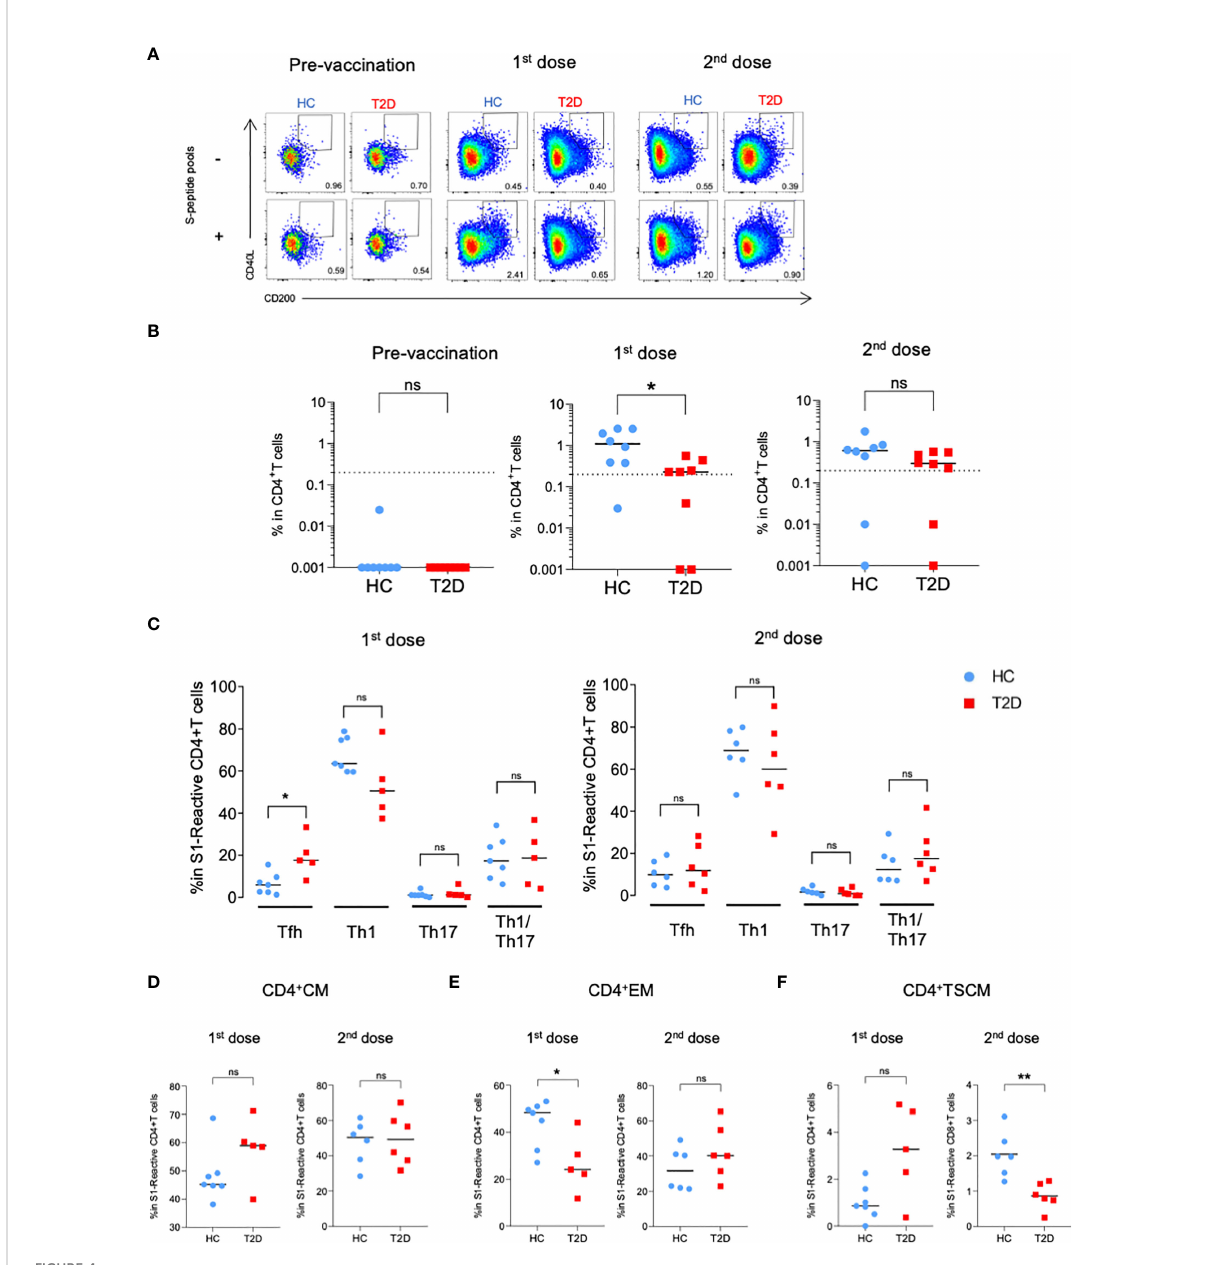
FIGURE 4 S1-reactive CD4 + T Cell responses shortly after BNT162b2 vaccination. A cohort of HCs and type 2 diabetic patients (n=8/group) were recruited for time course analysis of immune responses following BNT162b2 vaccination. PBMCs collected at pre-vaccination, 20 days after the 1 st dose and 14-20 days after the 2 nd dose of injections were stimulated with S1 peptide pools. (A) Representative fl ow cytometry plots depicting the gating of CD40L + CD200 + (gating) to identify antigen-reactive CD4 + cells following peptide stimulation. Dotted line represents the limit of detection. (B) Proportions of S1-reactive CD4 + T cells. (C) Proportions of CD4 + T cell subsets in S1-reactive CD4 + T cells (n=5-7/group). Tfh, CXCR5 + ; Th1, CXCR5 - CXCR3 + CCR6 - ; Th17, CXCR5 - CCR6 + ; Th1/17, CXCR5 - CXCR3 + CCR6 + . (D-F) Proportions of memory T cell subsets in S1- reactive CD4 + T cells(n=5-7/group). (D) central memory (CM), CD45RA - CCR7 + . (E) effector memory (EM), CD45RA - CCR7 - . (F) T stem cell memory (TSCM), CCR7 + CD45RA + CD27 + CD95 + . Data shown are median and each symbol represents an individual (B-F) . ns: not signi fi cant;